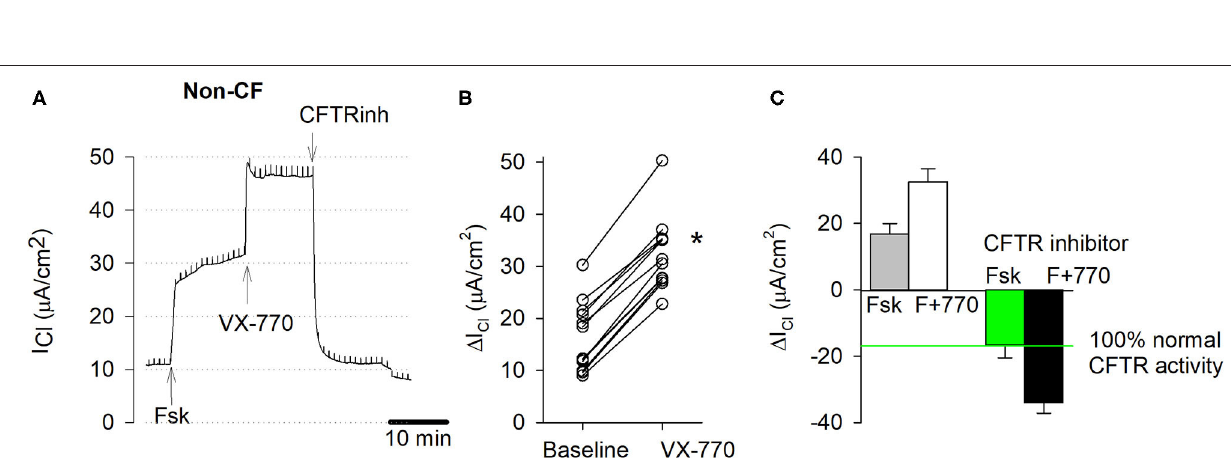
Frontiers in Pediatrics |